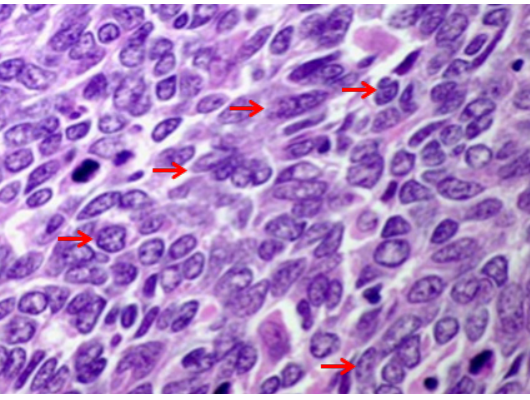
Legend: Figure 2 showes a single ill-defined hyperintense lesion (red arrows) measuring 6 x 5 cm in the left cerebellum extending to the right cerebellum. The lesion was surrounded by hypointense area suggestive of brain edema. Figure 3. Higher Magnification of the Small Cell Lung Cancer Showing Numerous Mitotic Figures (red